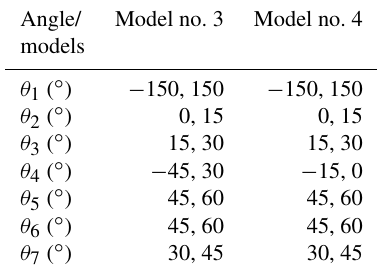
Table 3. Simulation result using the models with different con- straint functions.